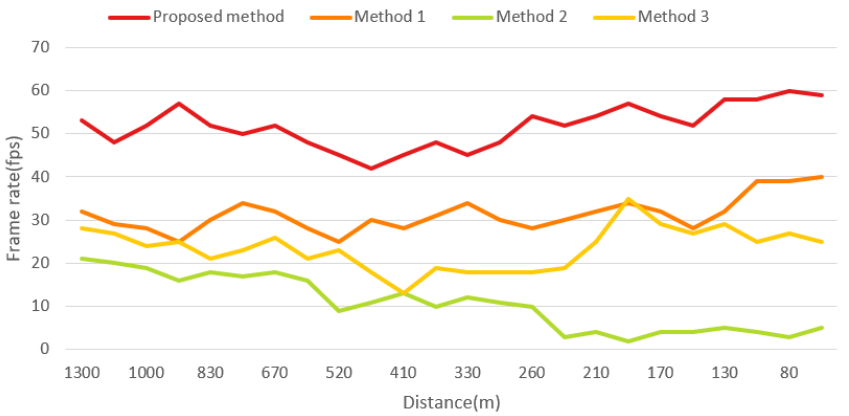
Figure 11. Fps afforded by the methods at different viewing